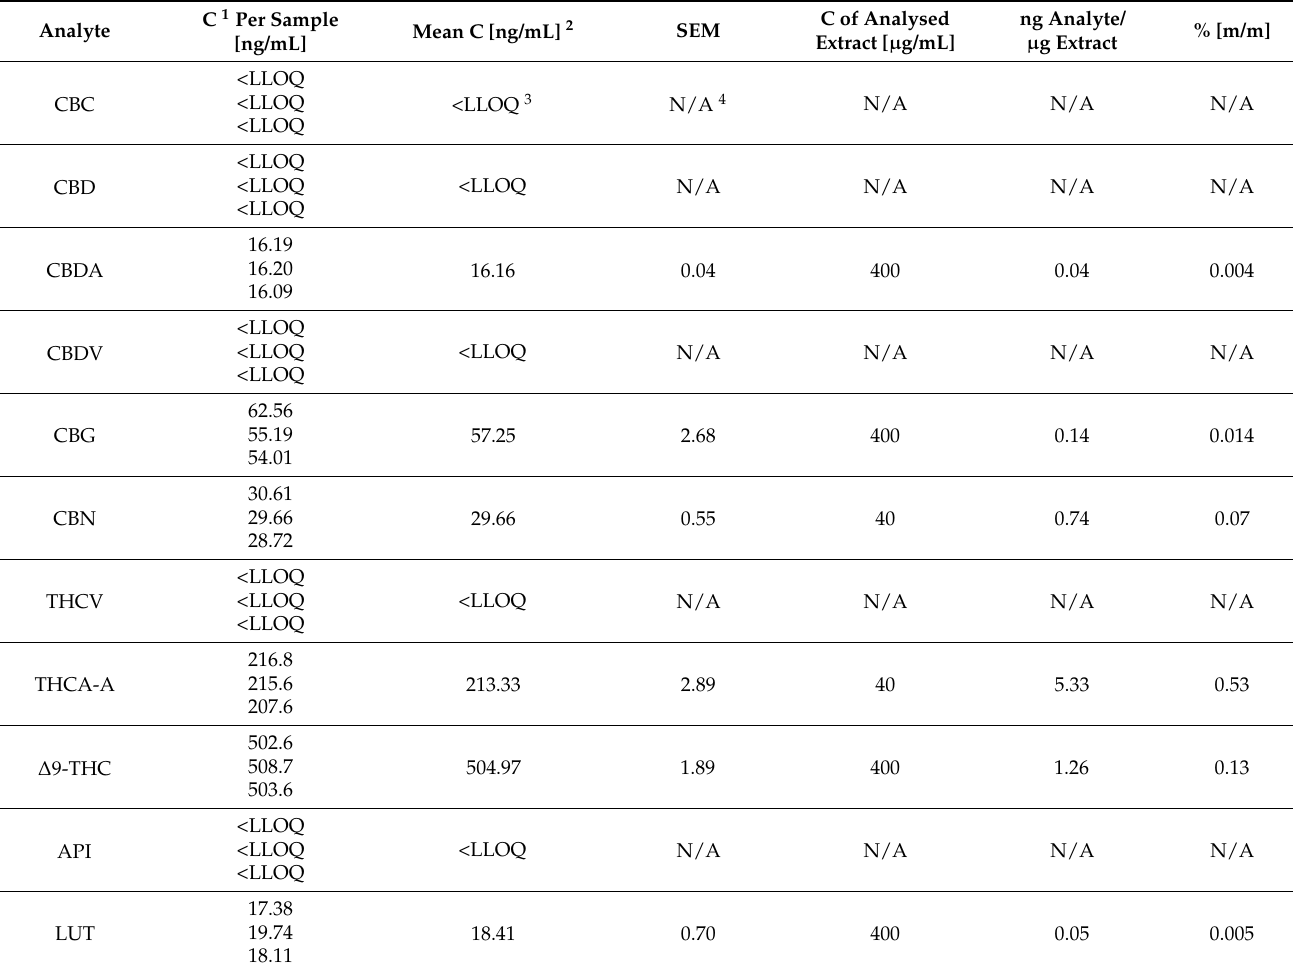
Table 3. Quantification of cannabinoids and flavonoids in THC-